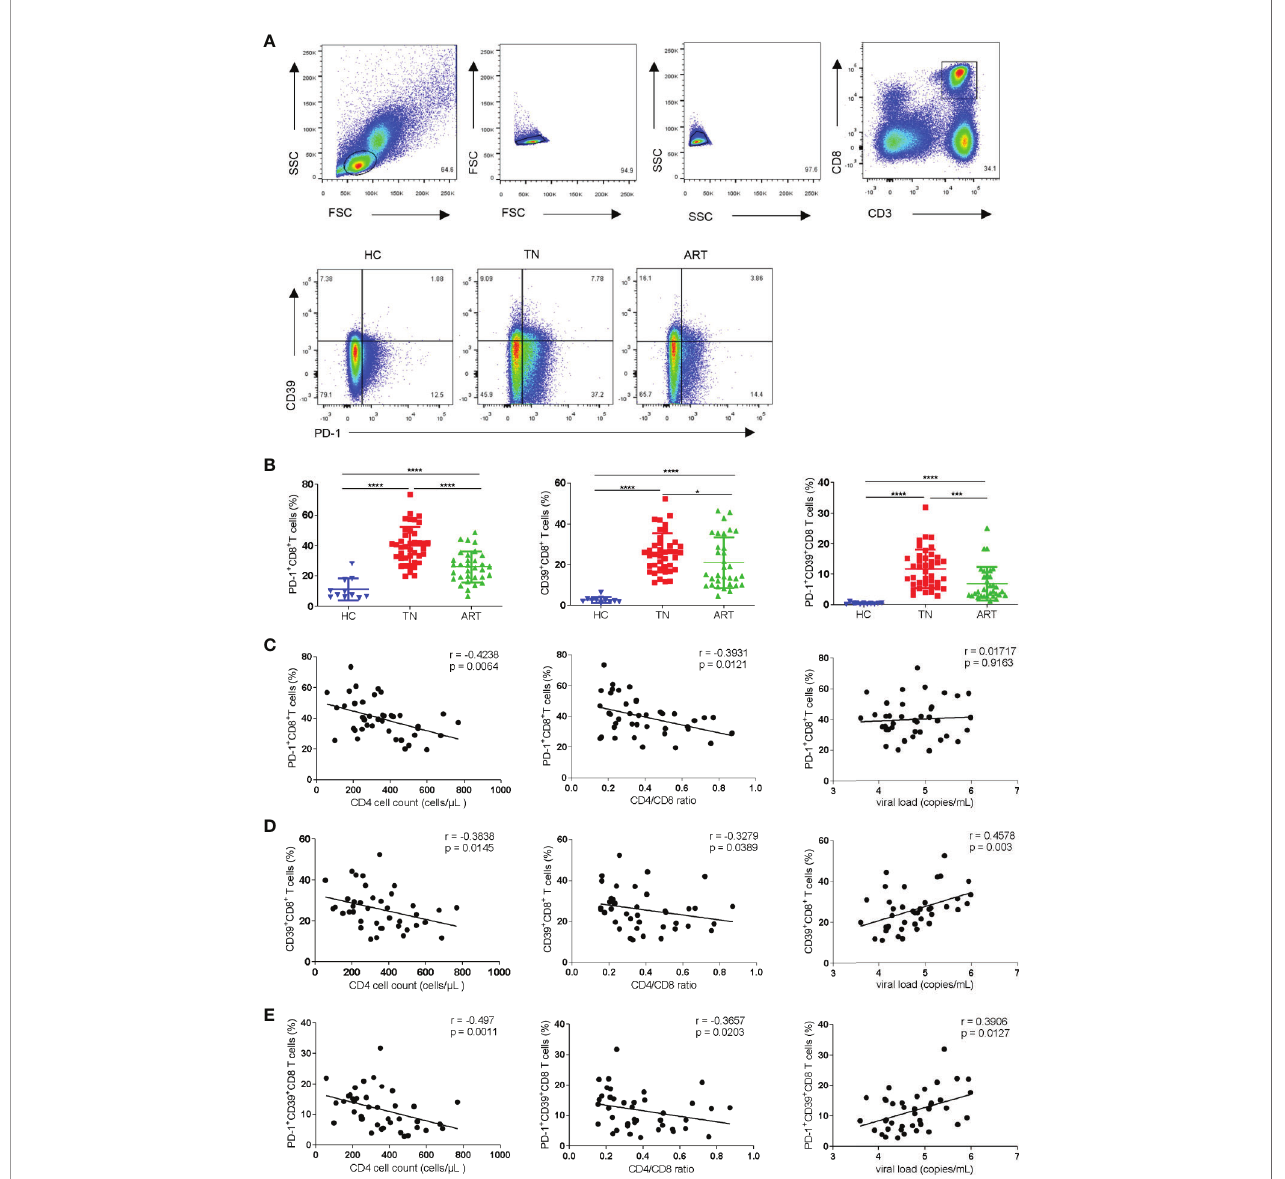
FIGURE 1 | Frequencies of PD-1 + CD8 + , CD39 + CD8 + , and PD-1 + CD39 + CD8 + T cells and their correlations with CD4 + T-cell counts, the CD4/CD8 ratio, and viral load in HIV-1-infected patients. (A) Gating strategy used for the fl ow cytometry analysis. Representative fl ow cytometry data for CD39 and PD-1 staining from the peripheral blood of healthy control and HIV-1 infected patients. (B) Comparison of the percentages of PD-1 + CD8 + T cells, CD39 + CD8 + T cells and PD-1 + CD39 + CD8 + T cells in healthy controllers (HCs), treatment naïve patients (TNs), and ART patients (ARTs). (C – E) Correlations between the frequencies of PD-1 + CD8 + (C) , CD39 + CD8 + (D) and PD-1 + CD39 + CD8 + (E) T cells with CD4 + T-cell counts, the CD4/CD8 ratio, and viral load in TNs. Each dot represents one individual. For the statistical analyses, a Mann – Whitney U-test was performed. Correlations were performed using a Spearman rank correlation test. Solid line, linear growth trend; r, correlation coef fi cient. P values are shown as *p < 0.05, ***p < 0.001, ****p <